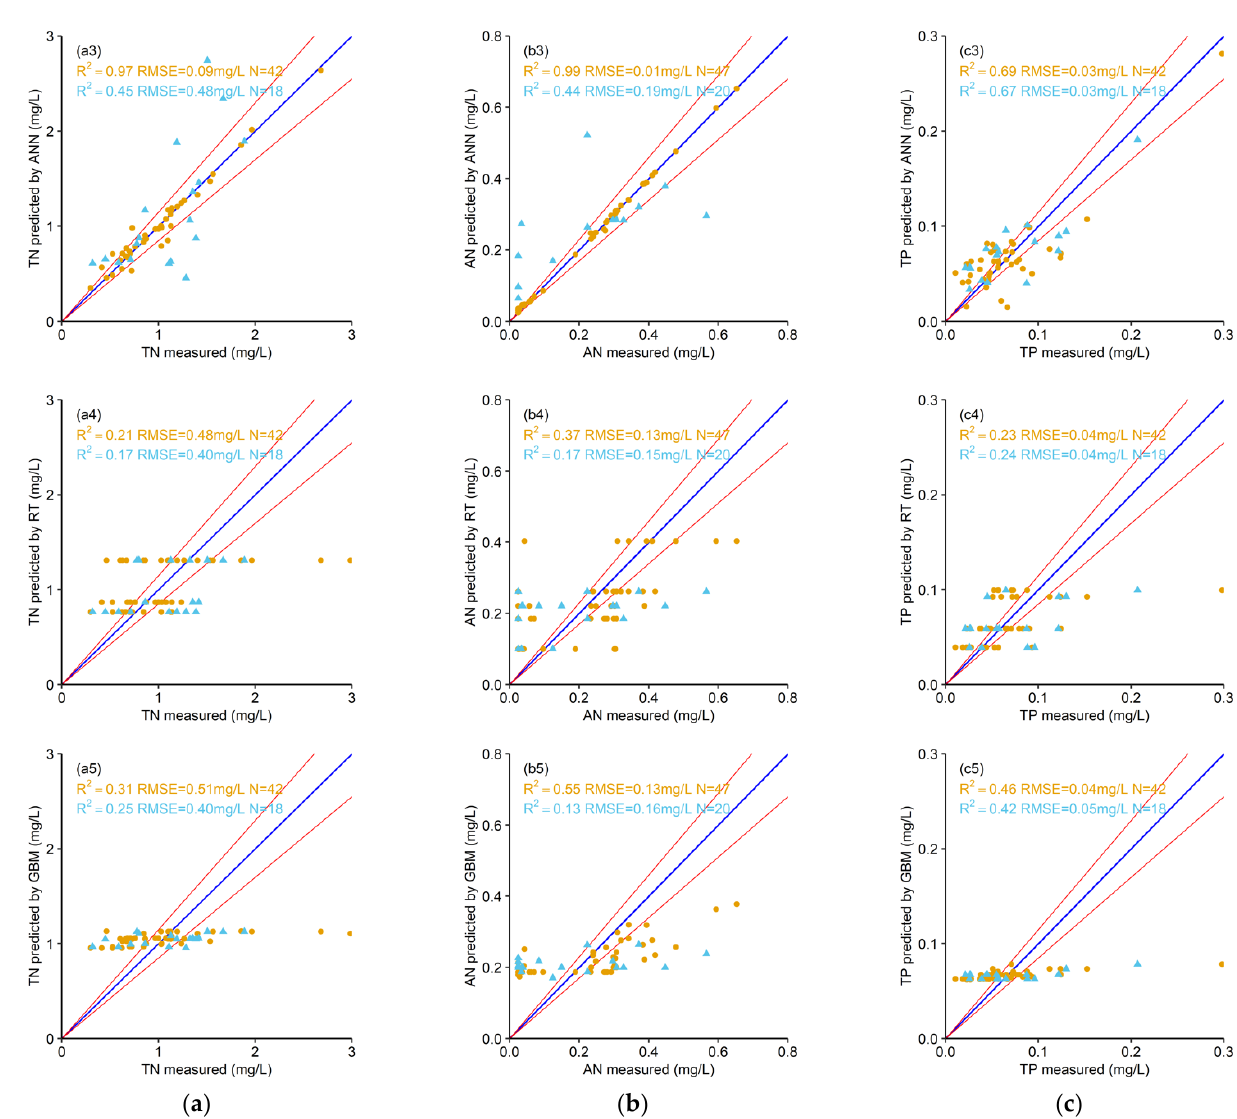
Figure 2. Relationships between in situ measured and Landsat 8 predicted TN ( a ), AN ( b ), and TP ( c ) for pixel – sample matchups. ( 1 – 5 ) indicate different machine learning algorithms: SVR, RFR, ANN, RT, and GBM, respectively. The orange text and circles represent the training results, and the blue text and triangles represent the testing results. The blue line is 1:1, and the red line is 15% variation. Table 2. Comparison of different machine learning algorithms for the training and testing datasets.